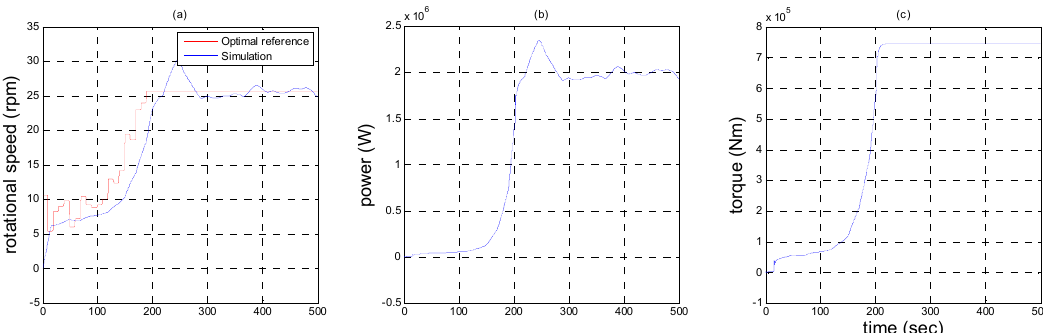
Figure 23. Generator performance in Region 3: ( a ) Generator speed; ( b ) Output power; ( c ) Electromagnetic torque.